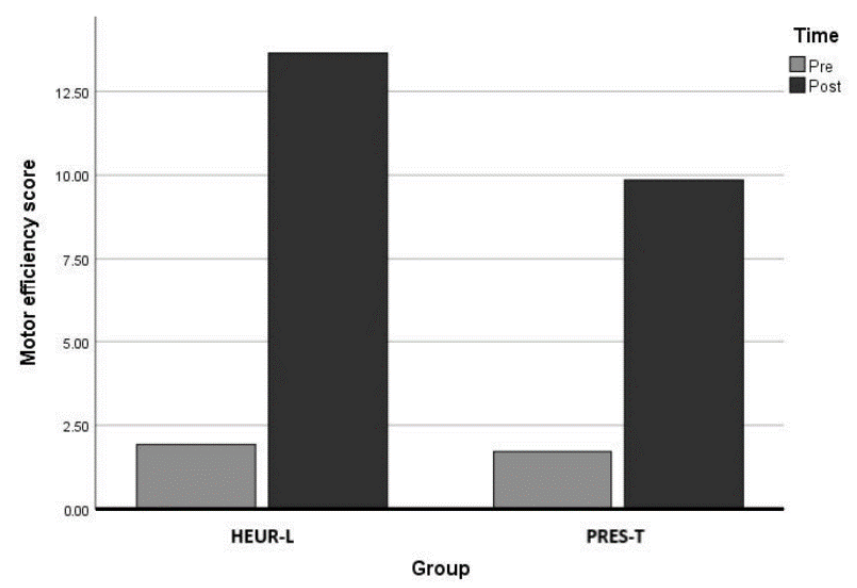
Figure 1. Differences in motor efficiency score according to group and